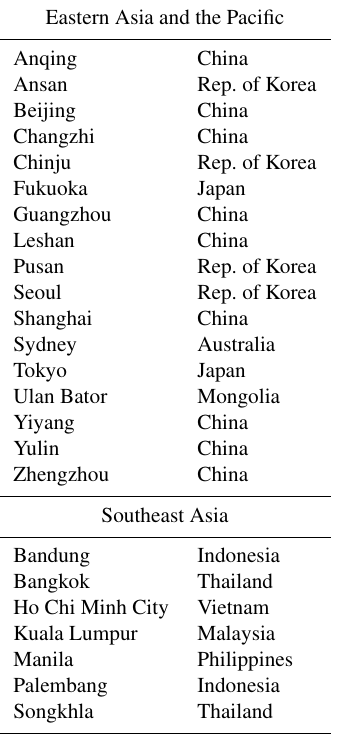
Table 1. City list arranged alphabetically by country and